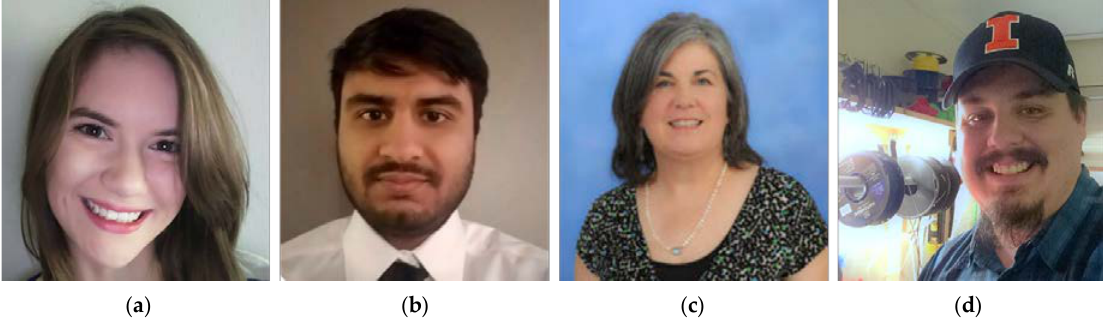
Figure 1. Mr. Patterson’s research group.